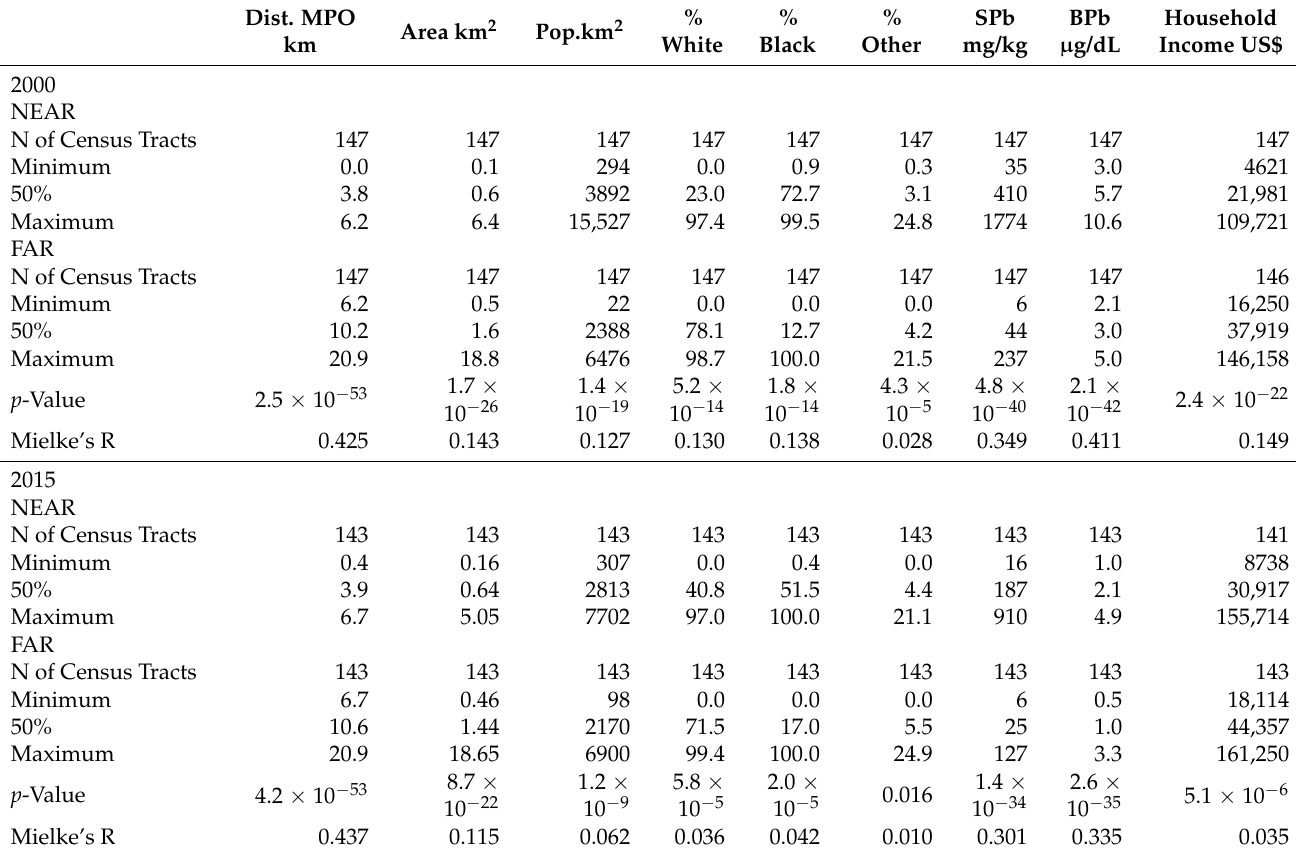
Table 1. The percentage of White, Black, and Other populations, median interpolated soil Pb, median interpolated blood Pb, and median household incomes in 2000 and 2015 for NEAR and FAR groups from the main post office. The median household income data are from IPUMS